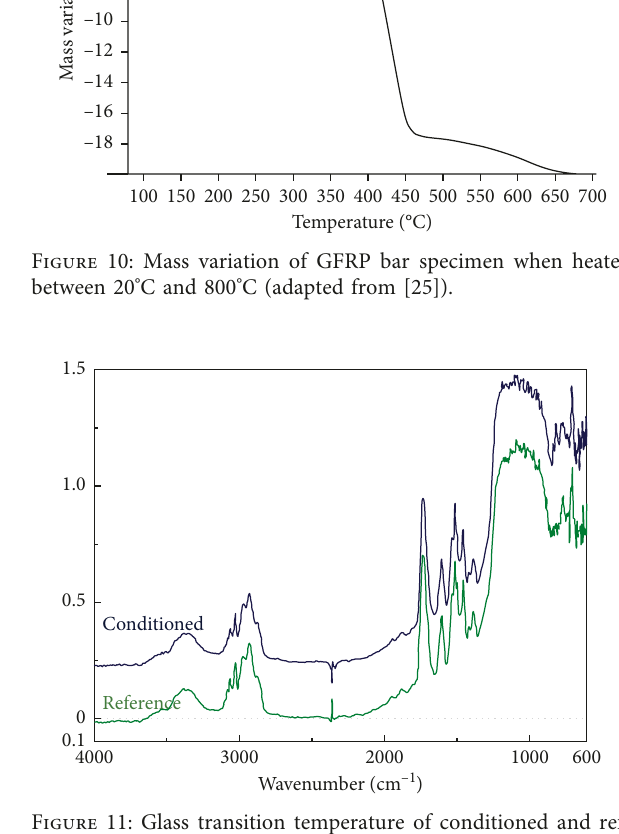
Figure 11: Glass transition temperature of conditioned and ref- erence GFRP bars (adapted from